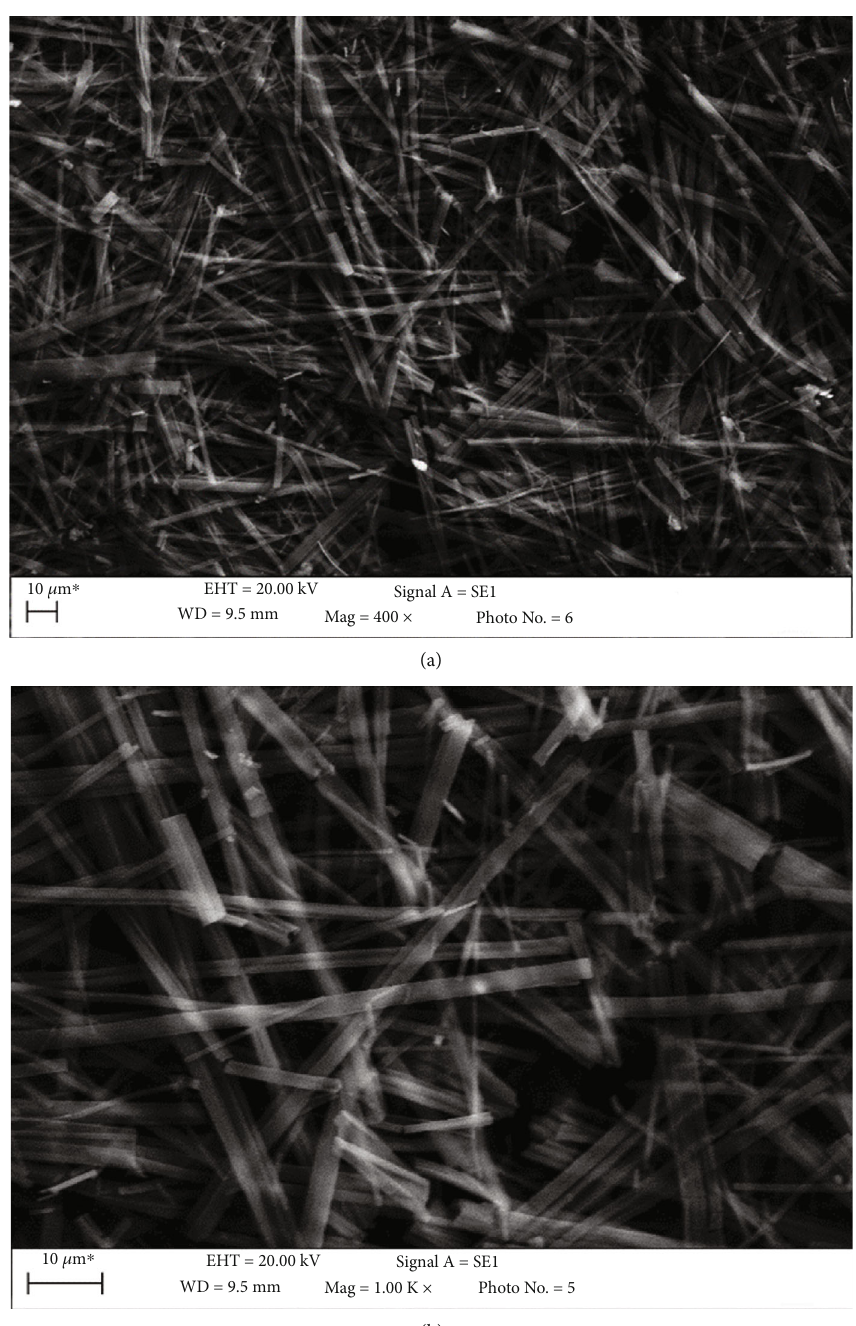
Figure 12: SEM image of P2 xerogel (THF) at 400 times (a) and 1000 times (b) magni fi